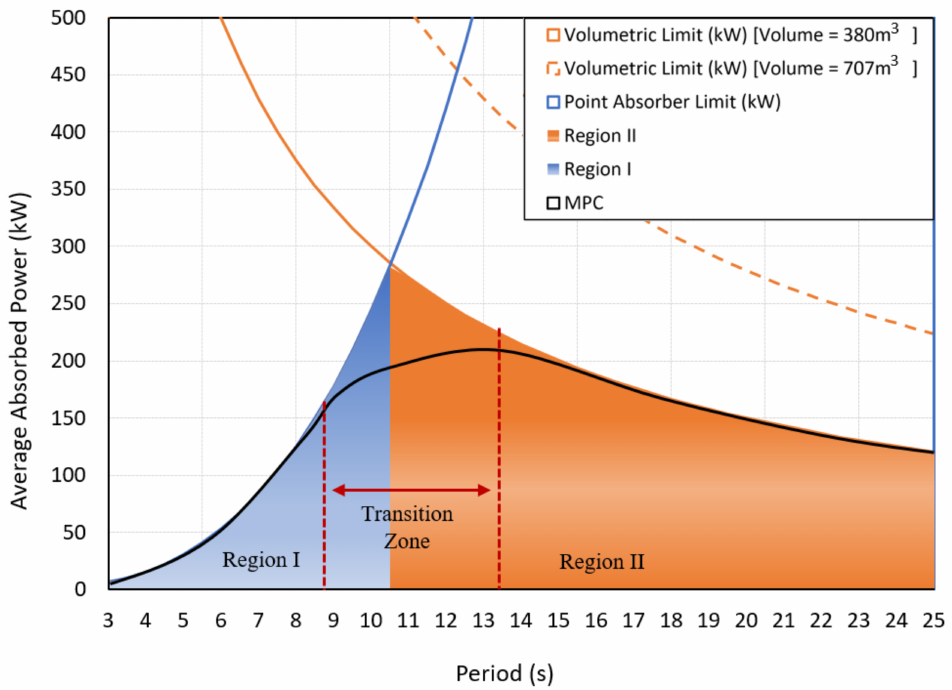
Figure 5. Controller design trade-off space based on theoretical limits for sinusoidal wave inputs of height H = 1